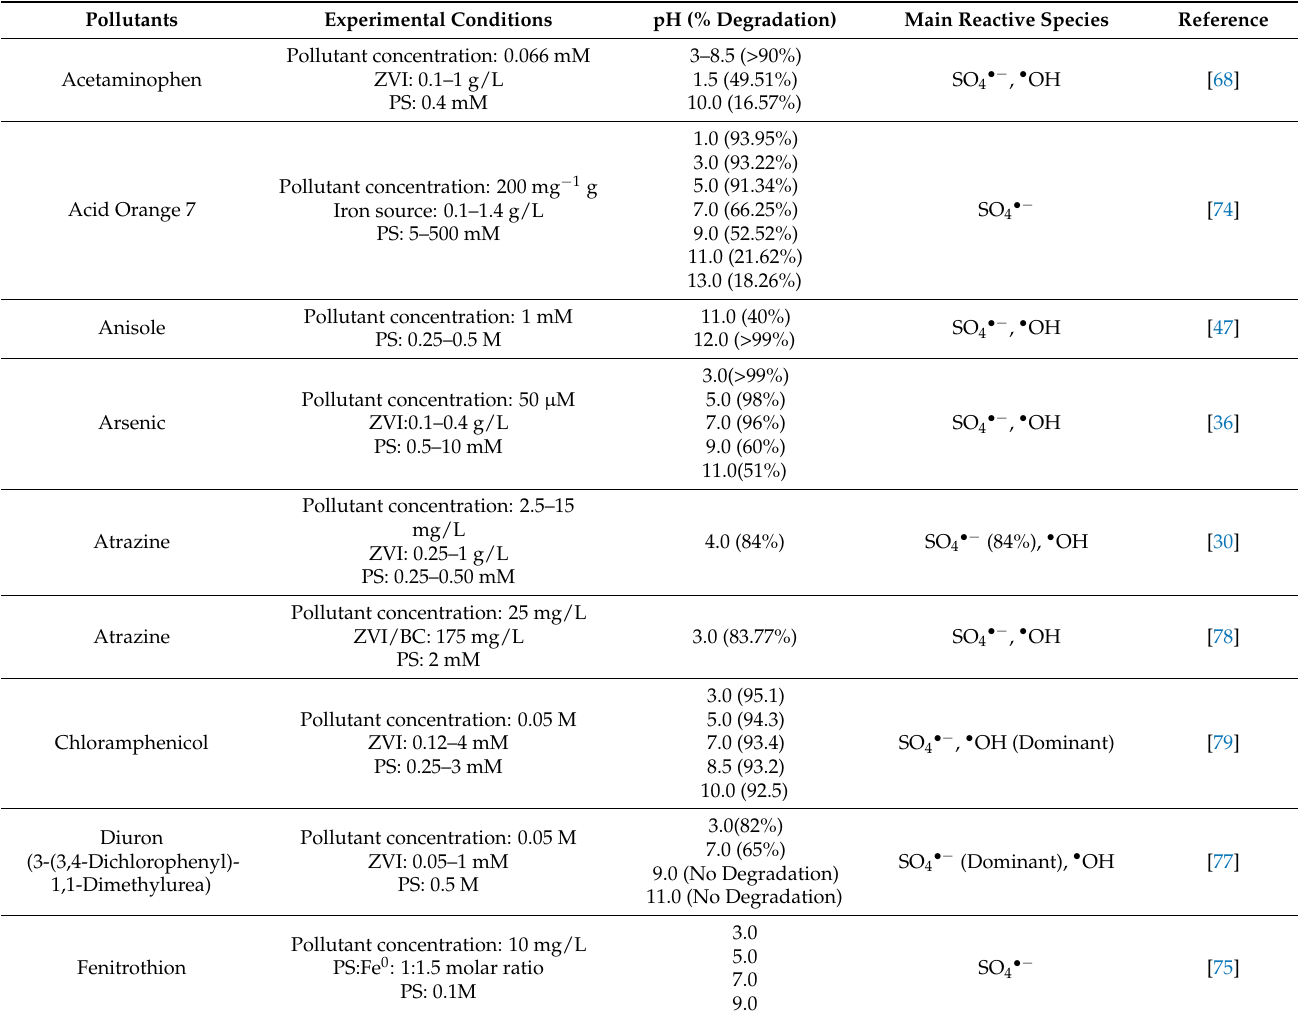
Table 1. Summary of the effect of pH along with generation of respective radicals with different pollutants. Note that Psi = porous